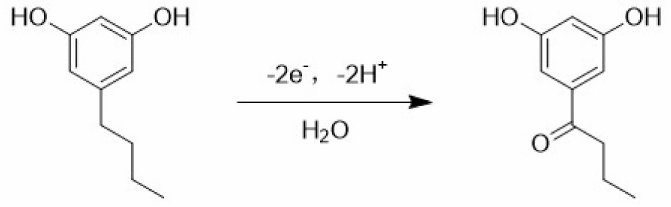
Figure 5. Possible mechanism of the electrooxidation of